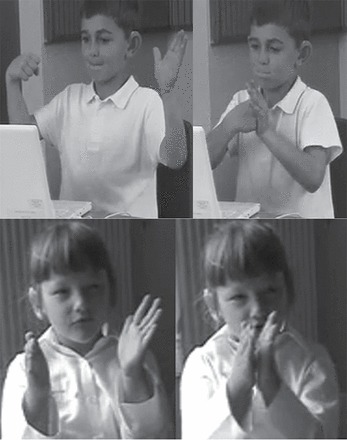
Two representations of the action of Wallace hitting the wall.